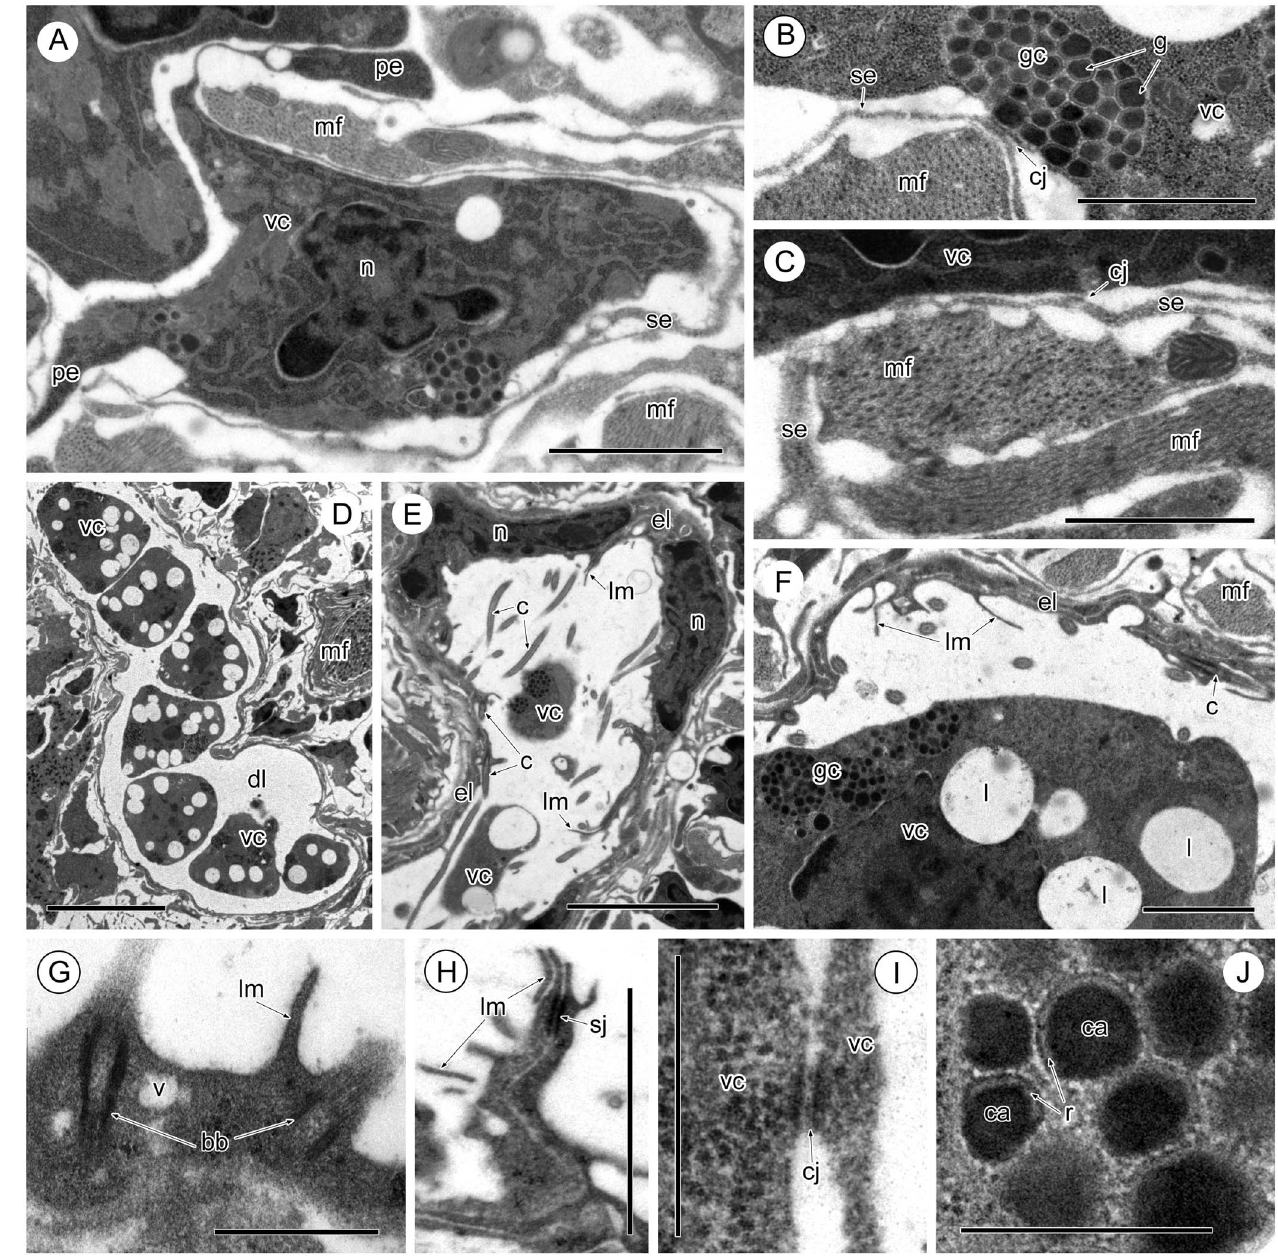
Figure 3. Vitelline cells (A – C, I, J) and vitelline duct (D – H) of Sanguinicola sp. 2 from ides. (A) Vitelline cell showing the various shapes of the cytoplasmic extensions, note the presence of numerous muscle fi bres around this cell. Scale bar = 2 l m. (B) Intercellular junction between a vitelline cell and the thin, sarcoplasmic extension of a muscle cell. Scale bar = 1 l m. (C) Cell junction between a vitelline cell and a sarcoplasmic extension. Scale bar = 1 l m. (D) Part of the vitelline duct fi lled with mature vitelline cells. Scale bar = 10 l m. (E, F) Flattened, ciliated, epithelial lining of the vitelline duct showing the inter-epithelial nuclei of these cells. Scale bars = 5 l m (E) and 2 l m (F). (G) Region of the epithelial lining of the vitelline duct showing basal ciliary bodies and a short surface lamella. Scale bar = 0.5 l m. (H) Apical septate junction in the duct epithelium. Scale bar = 0.5 l m. (I) Intercellular junction between two vitelline cells. Scale bar = 0.5 l m. (J) Heterogeneous vitelline globules. Scale bar = 0.2 l m. Abbreviations: bb = basal body of cilium, c = cilium, ca = central area of vitelline globule, cj = cell junction, dl = vitelline duct lumen, el = epithelial lining of vitelline duct, g = vitelline globule; gc = globular cluster, l = lipid droplet, lm = lamella, mf = muscle fi bres, n = nucleus, pe = pseudopodium-like extension, r = lucid rim of vitelline globule, se = sarcoplasmic extension, sj = septate junction, v = vesicle, vc = vitelline